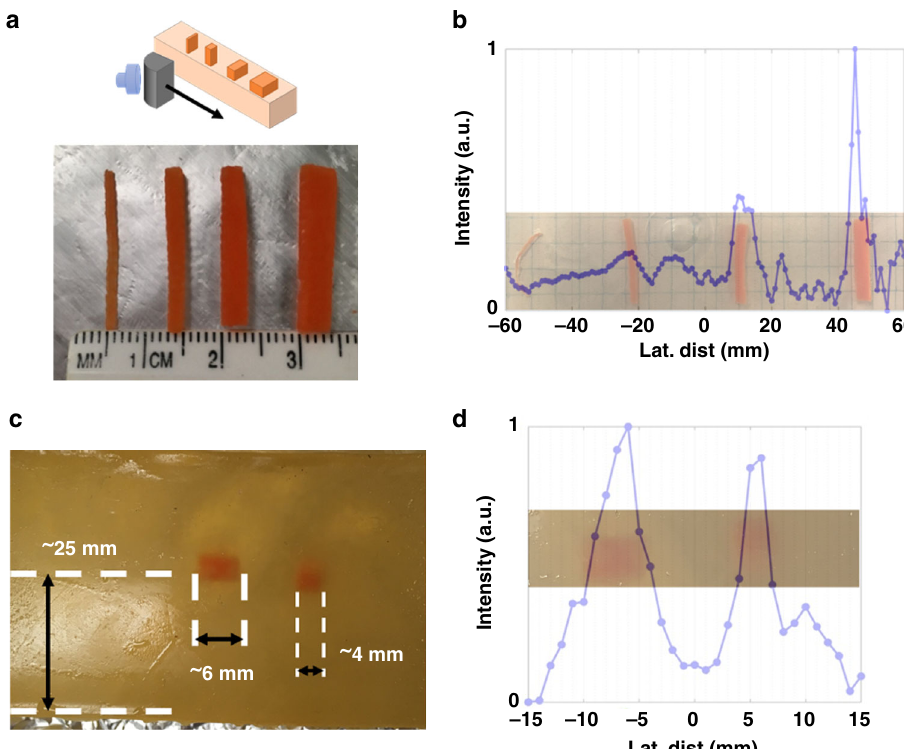
Fig. 5 Monostatic scan of organic masses in gelatin tissue phantom for acuity and lateral resolution. a Carrot tissue masses with lateral widths of 1 – 4 mm in 1 mm intervals. b ML lateral scan of biomasses overlayed with image of the sample. Samples larger than 0.72 λ are detected. c 6 mm and 4 mm rectangular masses in tissue phantom with lateral size and spacing> 1 λ . d Lateral scan of clearly shows the objects when overlayed with an image of the sample as known in the